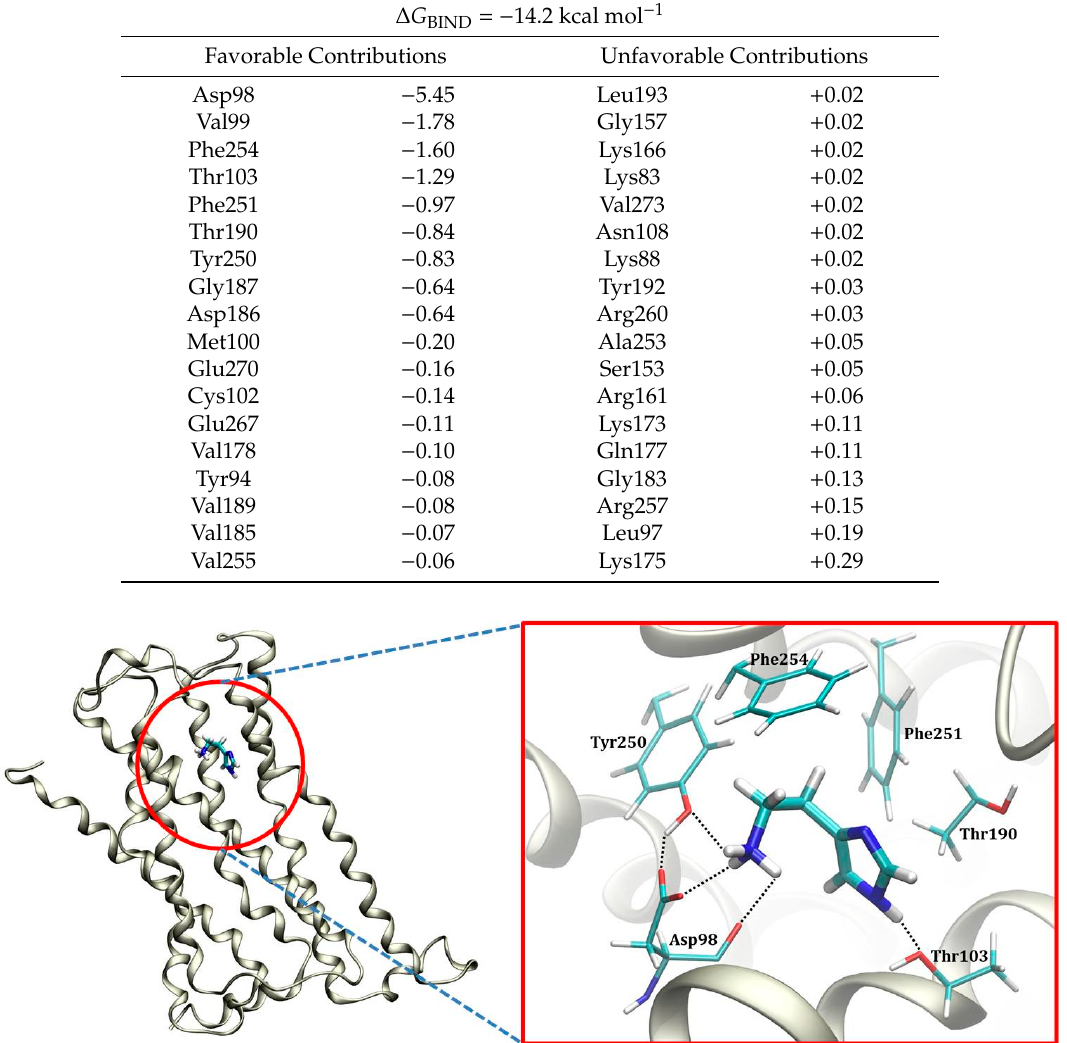
Figure 5. Representative position of the histamine monocation within the H 2 receptor binding site as obtained from the molecular dynamics simulation.